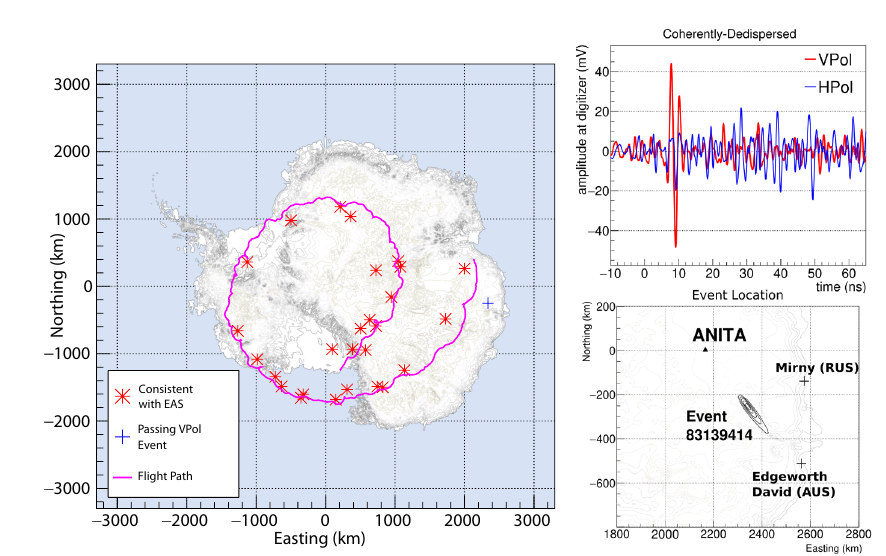
Figure 1. Left: The 26 EAS-like events that come from below the horizon found by any analysis (red), and the single remaining event in the most sensitive of the three Askaryan neutrino searches (blue). Upper Right: The coherently summed and dedispersed waveform for the single remaining event in the Askaryan neutrino signal region. Lower Right: The location (with uncertainties) of the event projected onto the continent, as well as the location of ANITA at the time of the event, and the closest known locations of human activity shown. From Reference